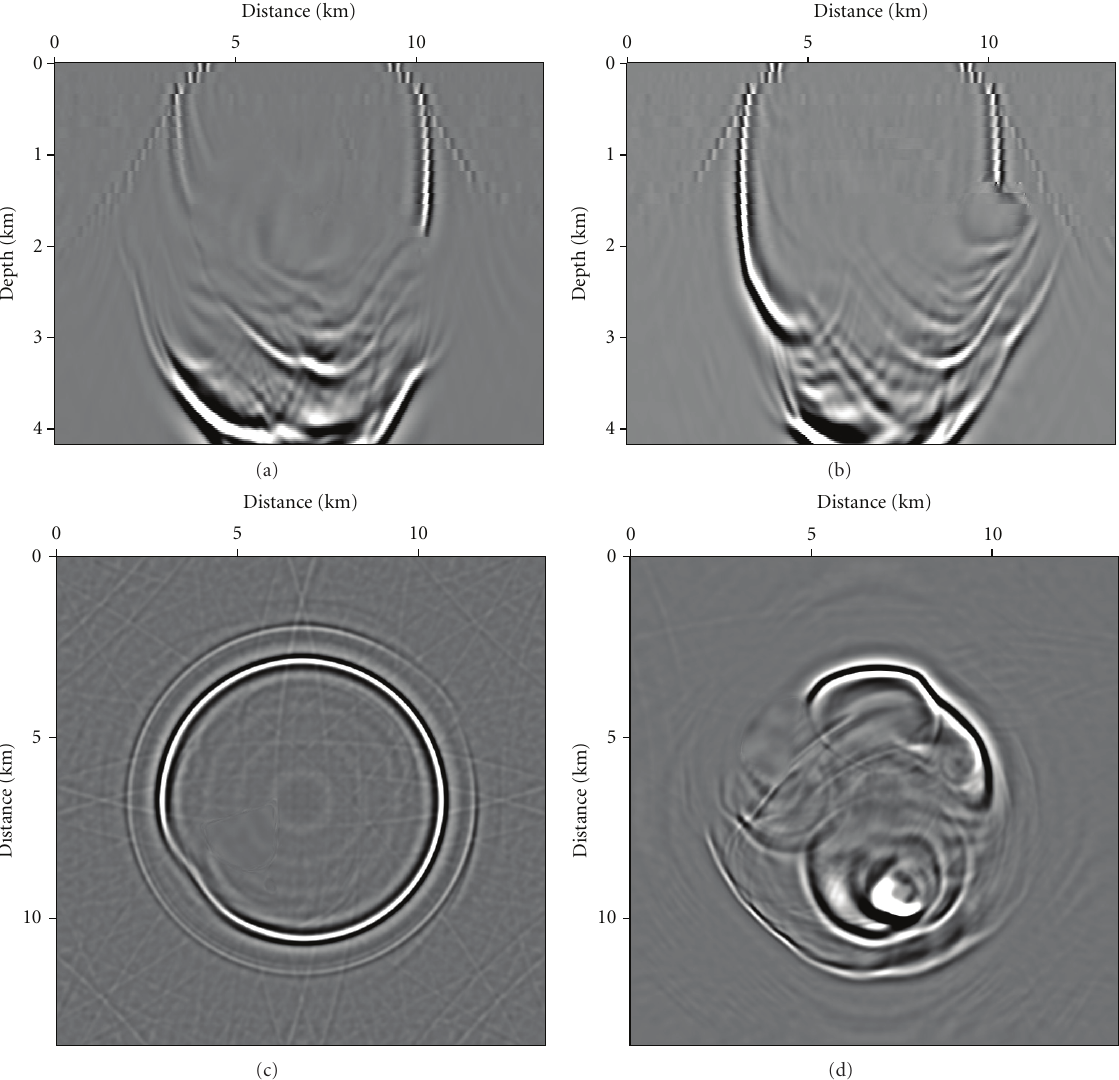
Figure 9: Impulse response obtained by FD migration using the complex Pad´e approximation with 3 terms with rotation angle of 45 ◦ and Li correction (cross-sections as